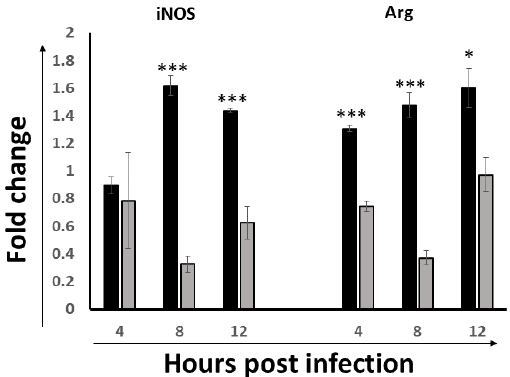
Figure 6. Differential modulations of M1 and M2 hallmarks in the ILP cells at the early stage of